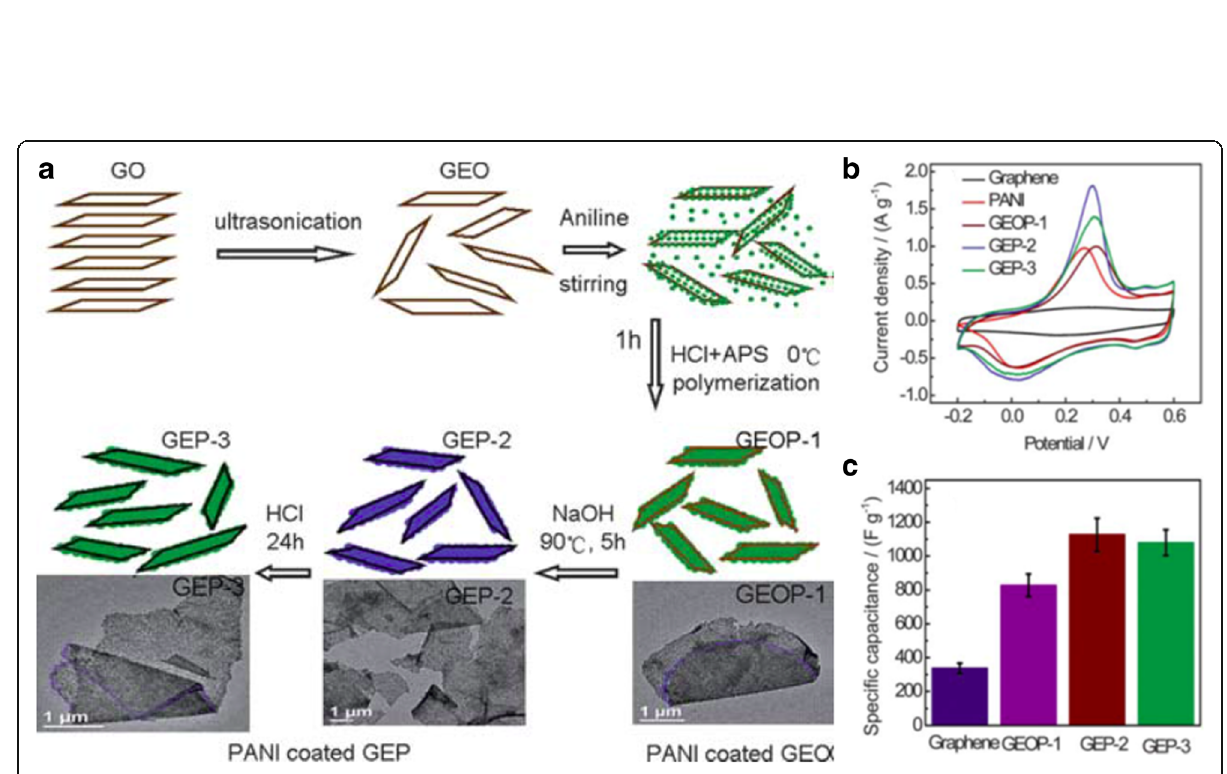
Fig. 6 a A scheme illustrating the preparation process of graphene/PANI hybrid materials. b CV curves of graphene, PANI, GEOP-1, GEP-2, and GEP-3, at 1 mV s − 1 in 1 M H 2 SO 4 in the potential range from − 0.2 to 0.6 V. c Specific capacitance changes with different samples. Reprinted with permission from [44]. Copyright 2010 Royal Society of